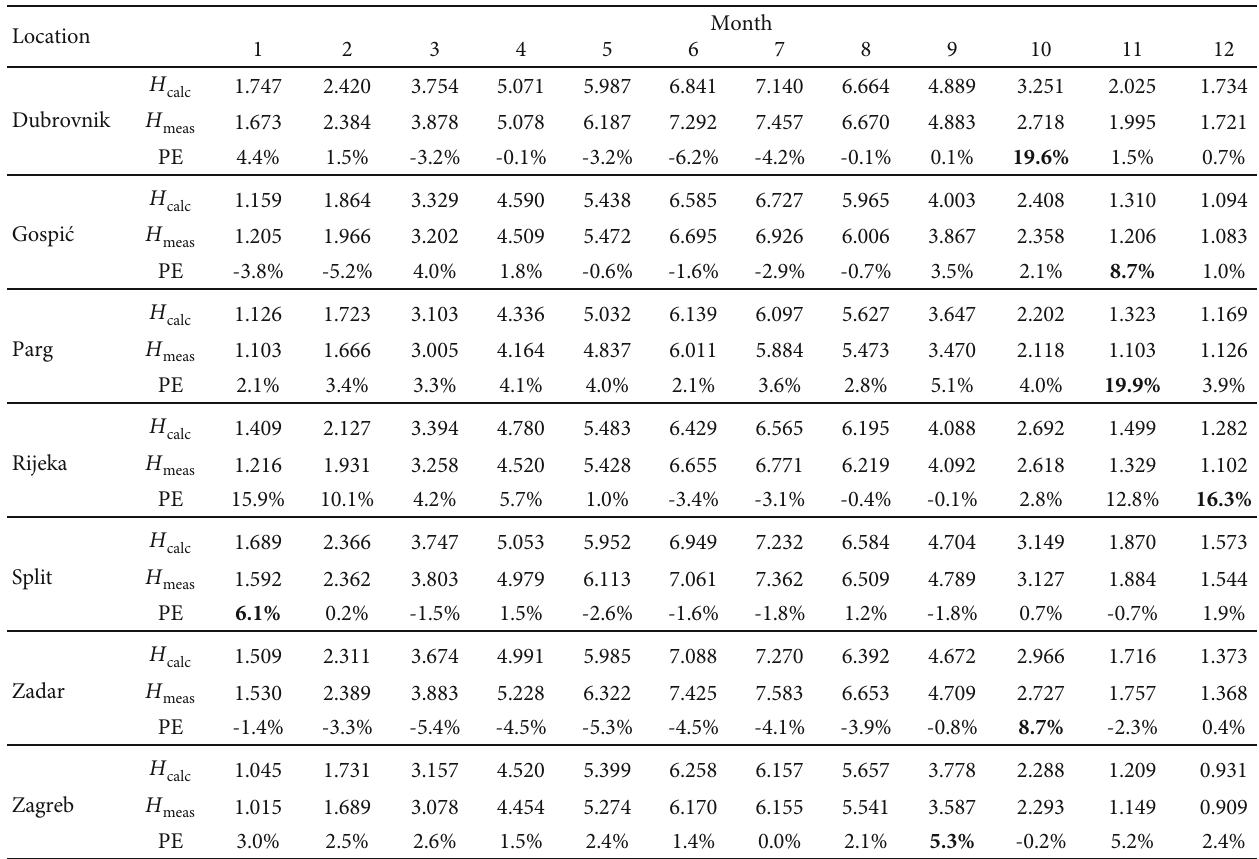
and H are in kWh/m 2 . calc meas